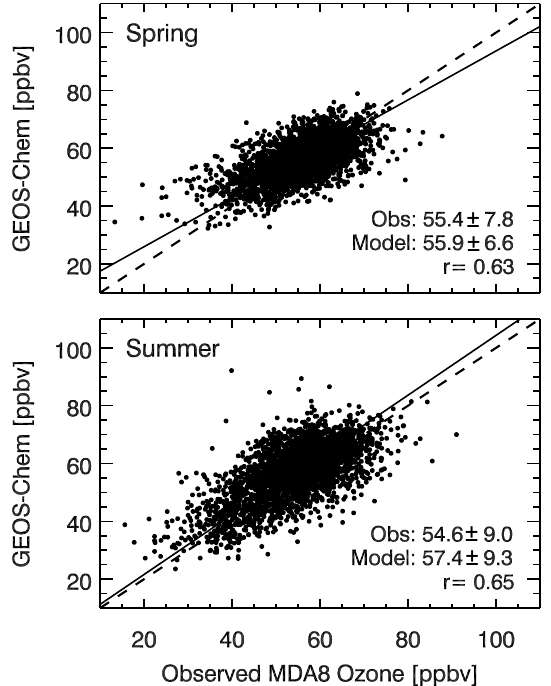
Figure 5. Simulated vs. observed daily maximum 8h average (MDA8) ozone concentrations at the ensemble of CASTNet sites in the Intermountain West (Fig. 4) for 2006–2008: spring (March– May; top panel) and summer (June–August; bottom panel). Each point represents a daily value for a site in Fig. 4. Also shown are the 1 : 1 line (dashed line) and the reduced-major-axis regression lines (solid lines). The mean concentrations, standard deviations, and correlation coefficients ( r) are shown inset.